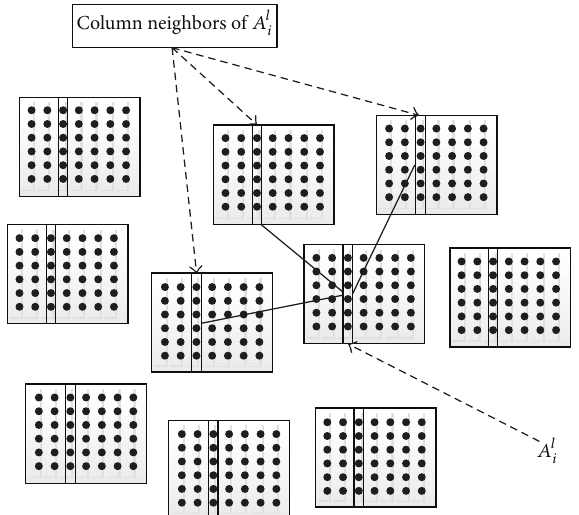
Figure 5: The 3 nearest neighbors of sample 𝐴 𝑖 ’s 𝑙 th column.